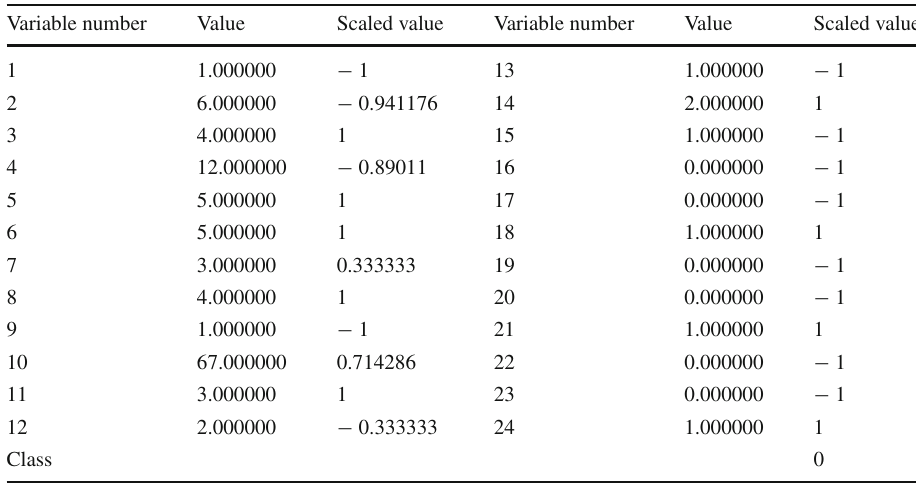
Table 1 An instance of the german.data-numeric dataset